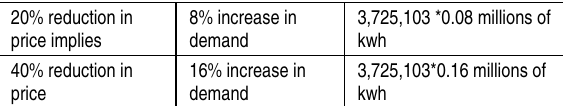
Table 3. Range of estimated number of plants needed for each drop in the price of